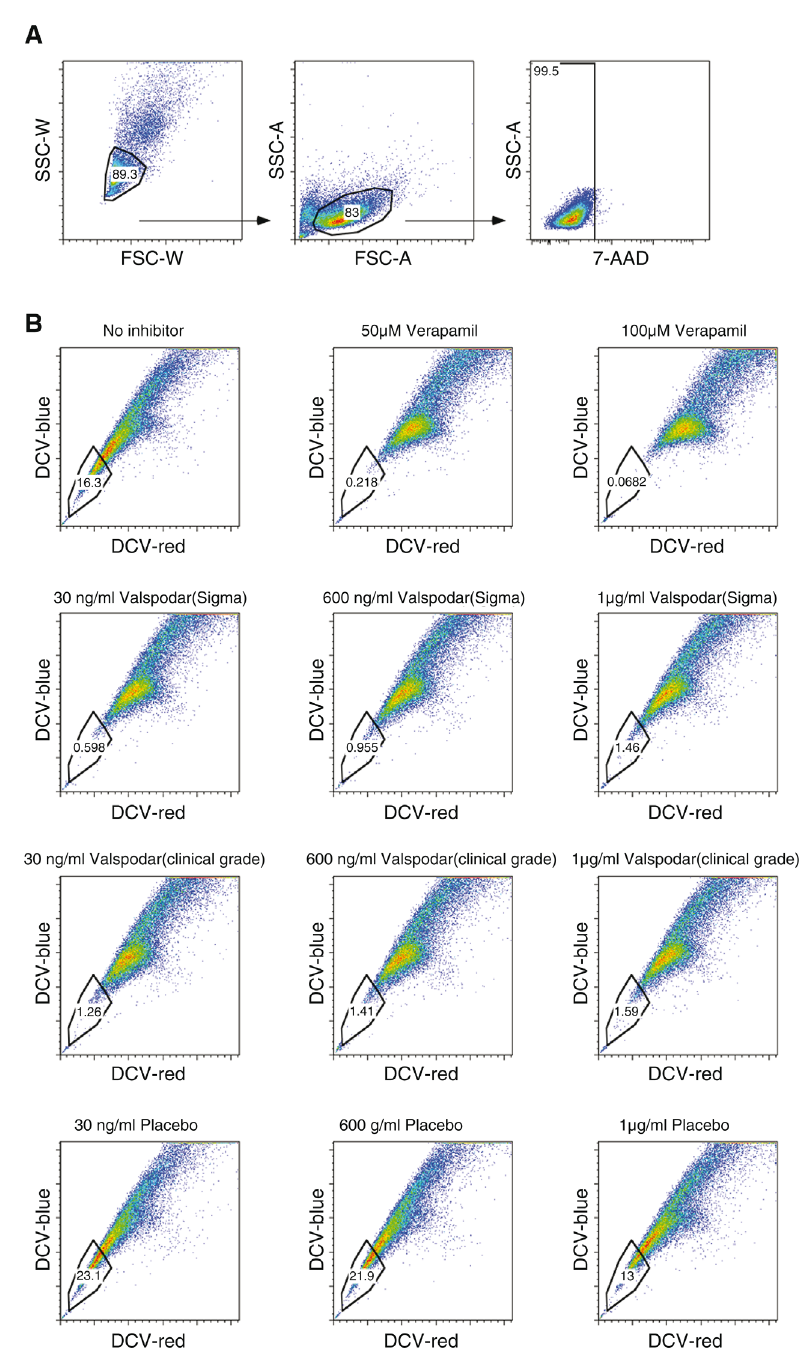
Figure 2. Valspodar inhibits dye excluding side population in canine hemangiosarcoma cells at clinically achievable concentrations. Side population analyses were done as described in Materials and methods using cultured COSB canine hemangiosarcoma cells. ( A ) Live cells were gated based on light scatter properties and exclusion of 7-AAD, and ( B ) the side populations were determined based on DyeCycle Violet (DCV) efflux. Verapamil was used to inhibit ABCB1 and ABCG2 at 50–100 µM concentrations. Clinical grade and research grade valspodar was used at concentrations that were achieved in the plasma of dogs in the study (30 – 600 ng/ml) as well as at the saturating dose of 1 µg/ml. The Y-axis is DCV-blue (450+/-50 nm) emission while the X-axis is DCV-red (660 +/- 40 nm) on the LSR-II. Data were analyzed and dot plots were created in